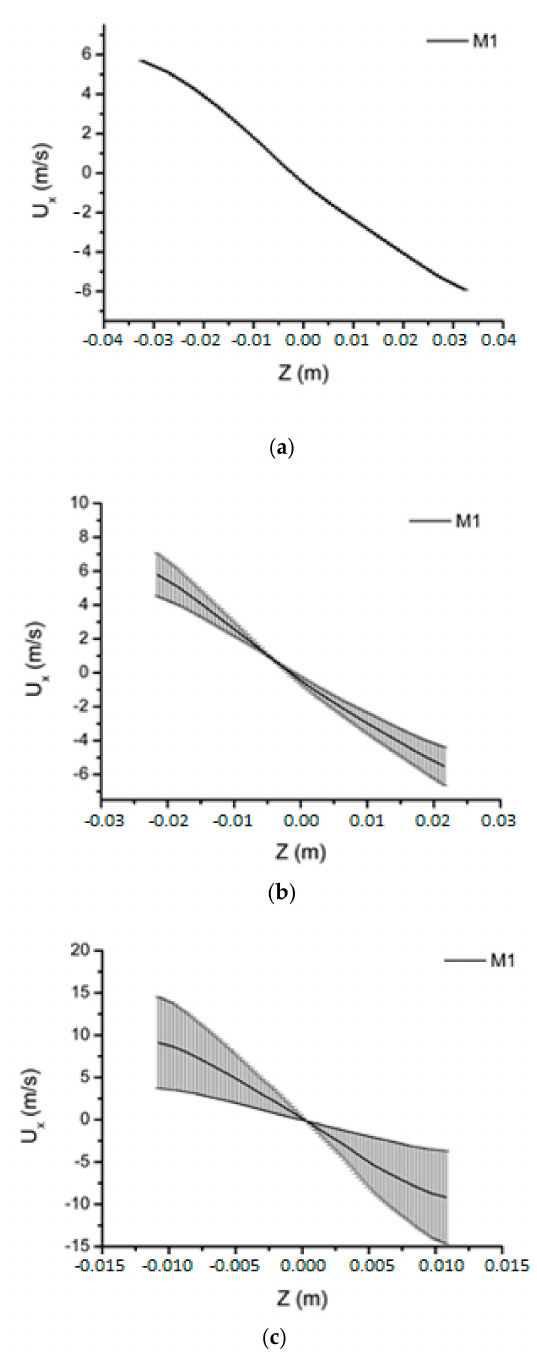
Figure 5. Water tangential velocity in the filtering cyclonic separator for the M1 mesh with ICM 21 in the form of an error bar. ( a ) y = 0.15 m; ( b ) y = 0.45 m, and ( c ) y = 0.75